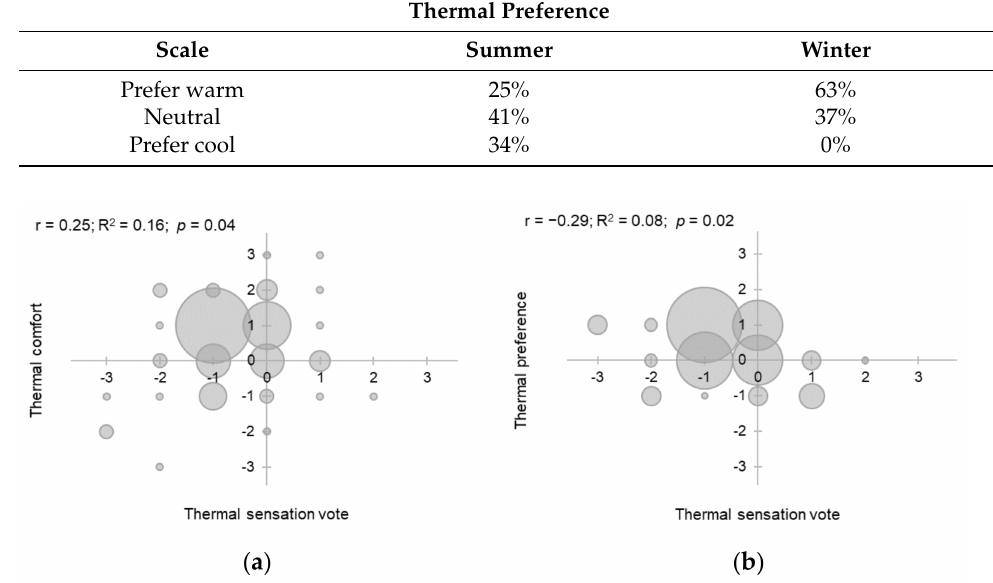
Figure 8. Correlation between: ( a ) thermal sensation and thermal comfort, and ( b ) thermal sensation and thermal